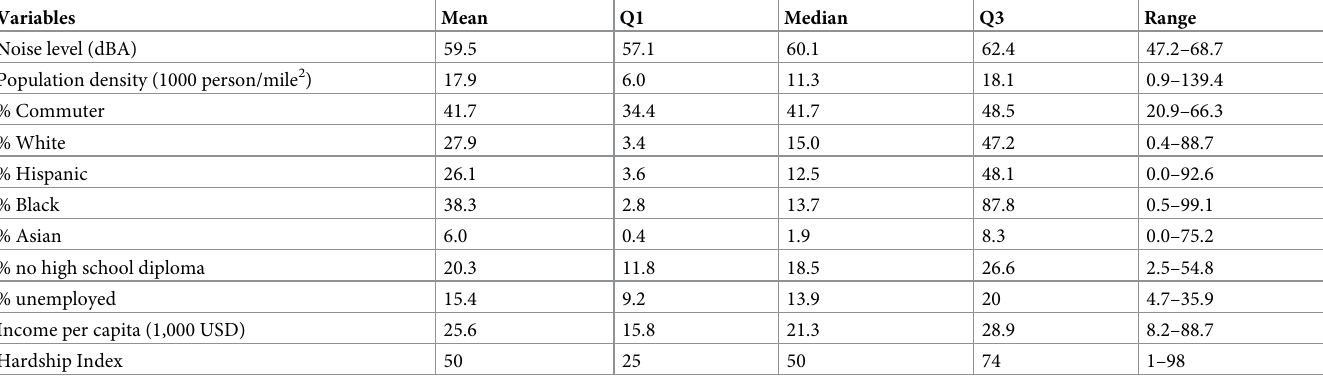
Table 3. Predicted daytime noise level and selected socioeconomic variables among 77 Chicago community areas.